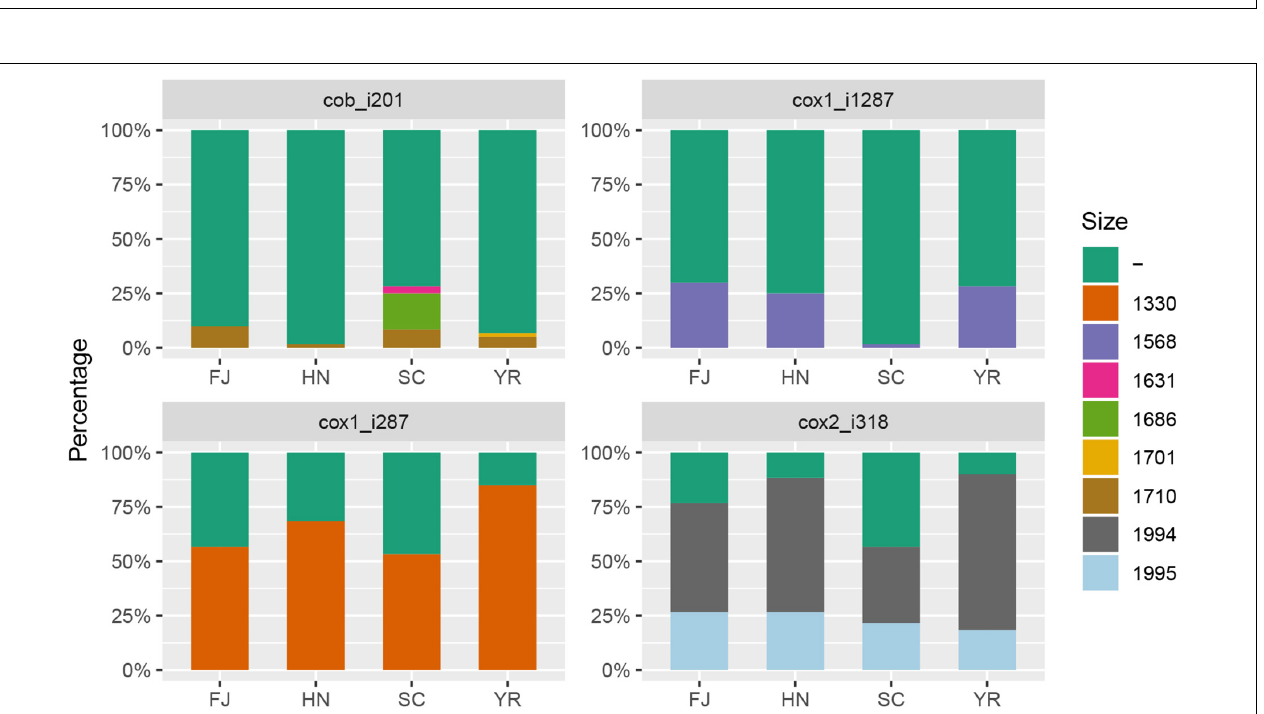
FIGURE 2 | The size composition of four introns: cox2_i318, cob_i201, cox1_i287, cox1_i1287. FJ, Fujian; HN, Hunan; SC, Sichuan; YR, Middle-Lower Reaches of Yangtze River. -: absence, and numbers indicate length of introns in base pairs.